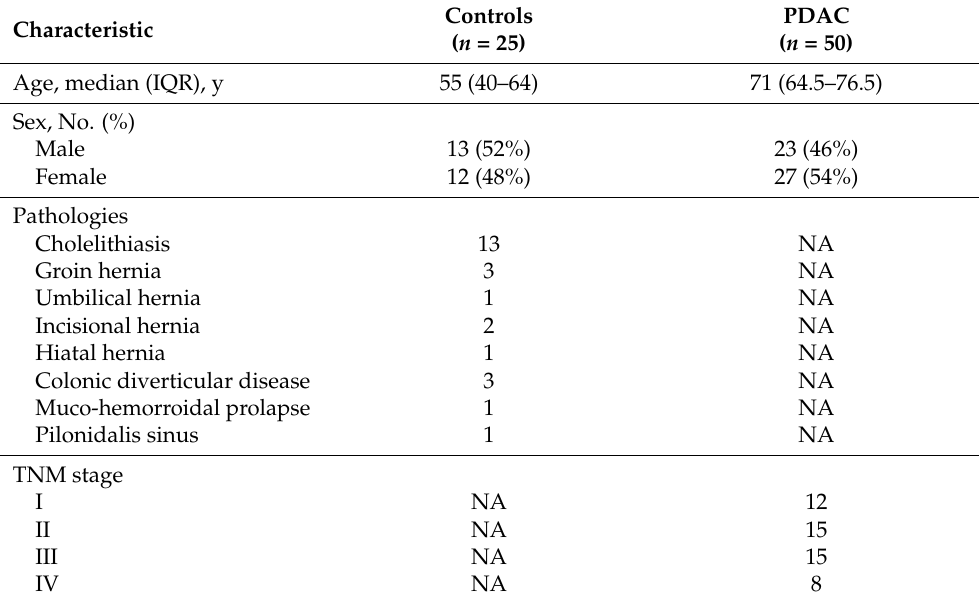
Table 1. Demographic and clinic characteristics of the control group and the pancreatic ductal adenocarcinoma (PDAC)